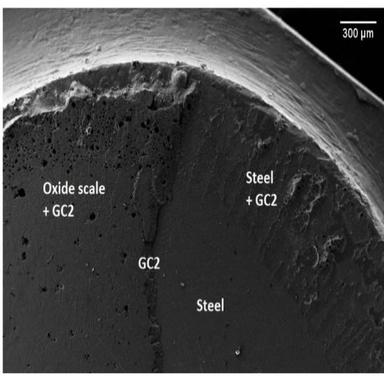
(a,b) typical polished cross-sections and (c) typical fracture surface after torsion for both THG-5 and THG-25 glass-ceramic 2 (GC2) joined samples after test at room temperature (τ = 49 ± 10 MPa and τ = 51 ± 17 MPa, respectively) (pictures refer to THG-25); (d) fracture propagation sketch (orange = glass-ceramic; grey = oxide scale; red = fracture propagation): mixed behavior, with GC2 partially present on both fracture surface, as verified in (e) by SEM-EDS, with each region identified (For interpretation